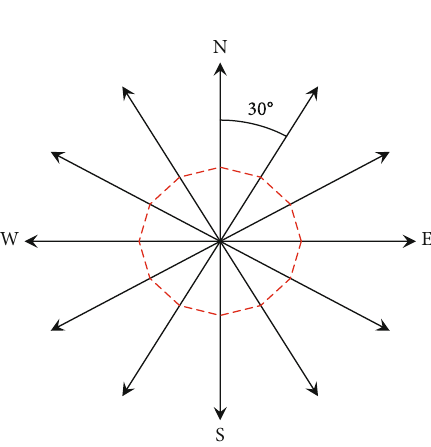
Figure 4: Schematic diagram of the survey line